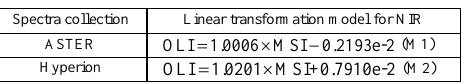
Figure 6. Same as Figure 5, but the statistics of modelling results are based on Hyperion spectra collection.